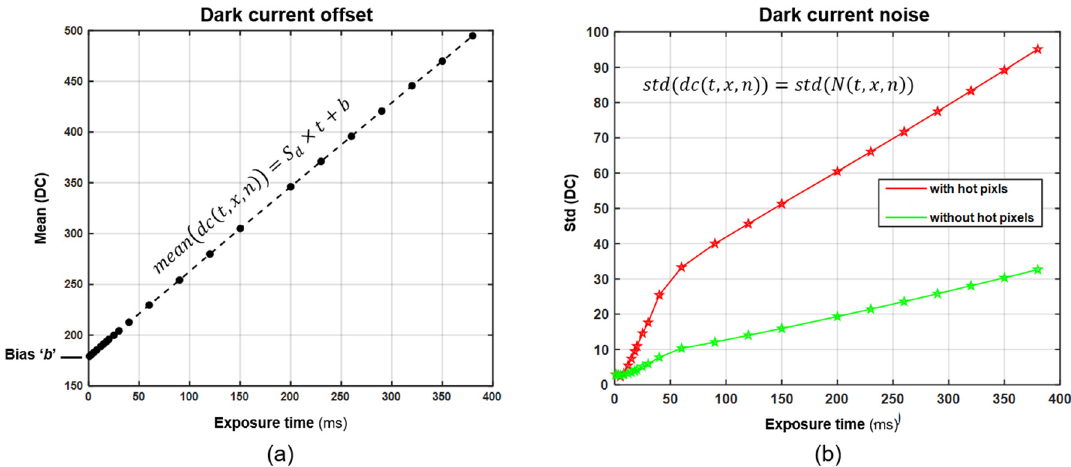
Figure 6. DC: ( a ) Mean DC vs. Exposure time, ( b ) Standard deviation of DC.